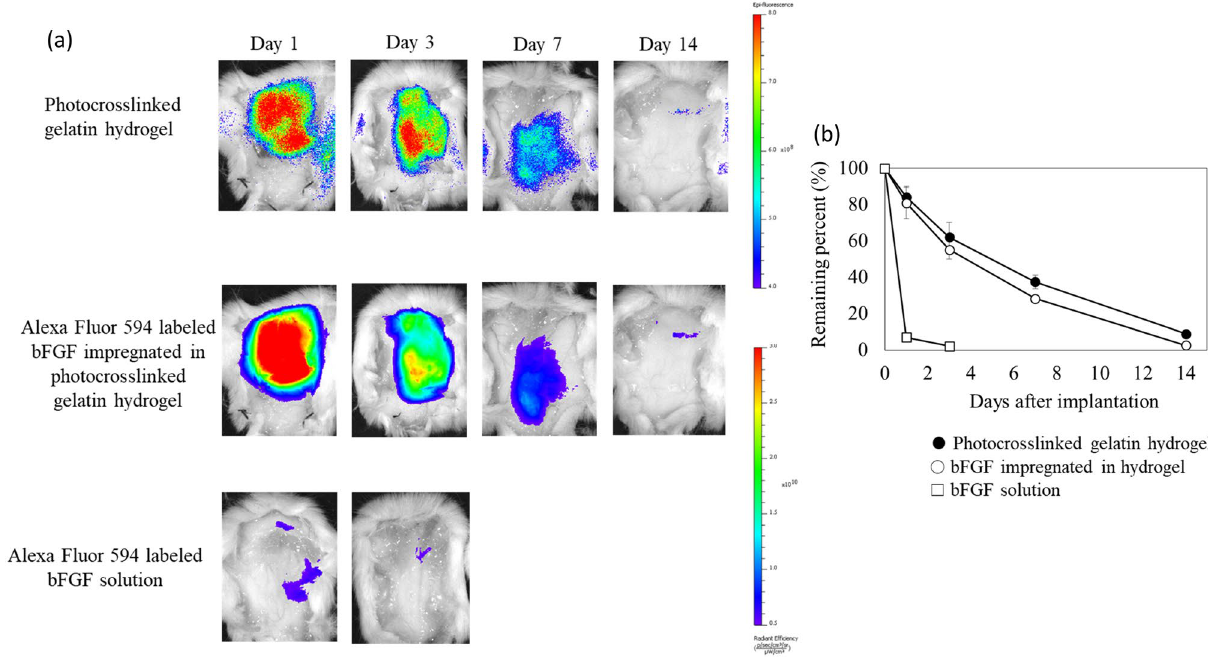
Figure 3. In vivo release of bFGF from photocrosslinked gelatin hydrogel. ( a ) Decreasing patterns of bFGF impregnated in photocrosslinked gelatin hydrogel after subcutaneous implantation into mice. The residual bFGF in the photocrosslinked gelatin hydrogels decreased with implantation time. In contrast, the aqueous solution of bFGF (without gelatin hydrogel) rapidly disappeared from the injected site within 3 days. ( b ) The time profile of bFGF retention was in good accordance with that of hydrogel degradation. These findings indicate the possibility that bFGF is released from the photocrosslinked gelatin hydrogel in the body due to hydrogel